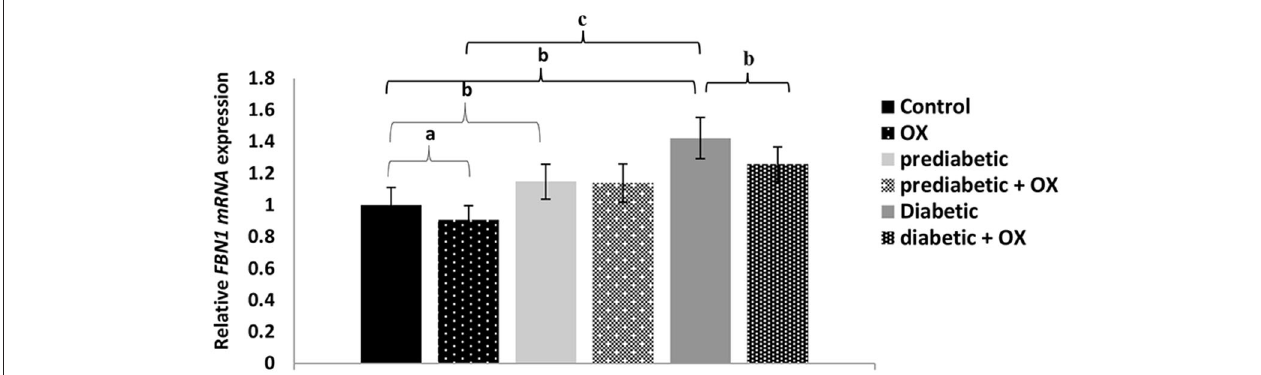
FIGURE 3 | Relative FBN1 mRNA expression (mean ± SEM) in different groups of Wistar rats. FBN1 , fibrillin-1 gene; OX, oxytocin. a P > 0.05, b P > 0.01, and c P >